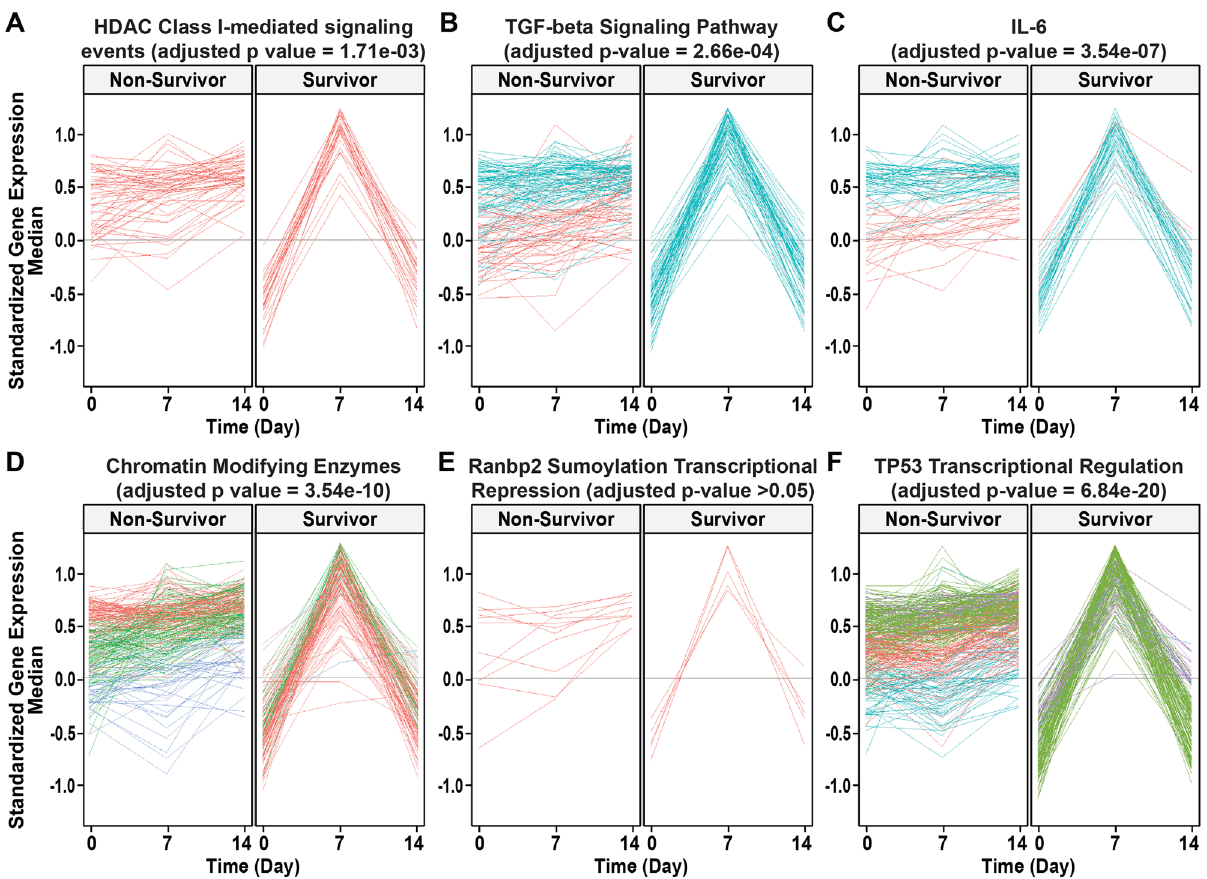
Figure 3. Shown are the changes in median pathway expression (gene set) between ARDS survivors and non-survivors for specifically identified pathways including HDAC ( A ), TGFβ ( B ), IL-6 (C ), Chromatin ( D ), sumoylation ( E ), and TP53 ( F ). Each line represents the gene expression of a pathway gene. The color of the line represented the cluster of the pattern, a line within the same group with the same color means the patterns of change for those genes are similar. For example, in the TGF-β signaling pathway, the gene expression change was homogeneous in the survivor group (all blue) while two clusters of patterns existed in the non-survivor group (blue and red). The adjusted p-value represented the significance of those patterns changes between groups. The color reflects the pattern of the gene expression change within that specific pathway and group (not use to compare groups or pathways). The red only lines in the HDAC pathway indicate non-survivor and survivor gene pattern change have only one pattern whereas in the TGFβ pathway non-survivors have two patterns (red and blue) but survivors only one